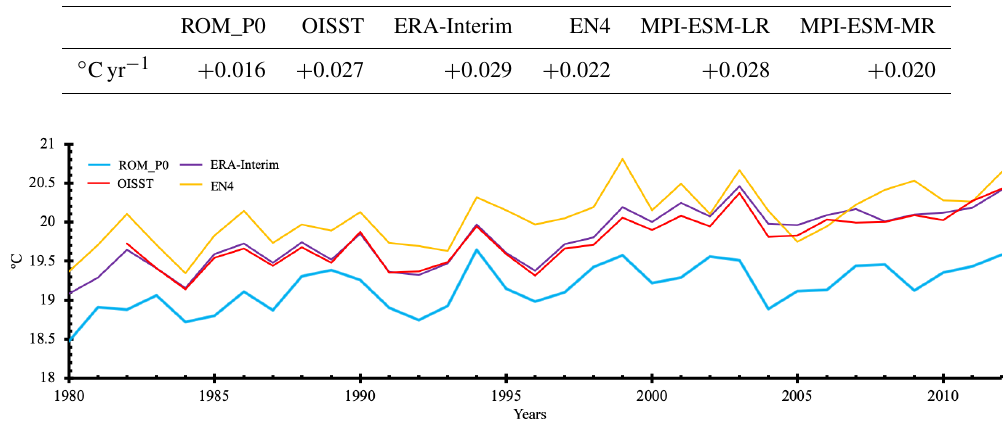
Table 3. Trend computed from yearly means during 1980–2012 by the different analyses of the Mediterranean Sea.